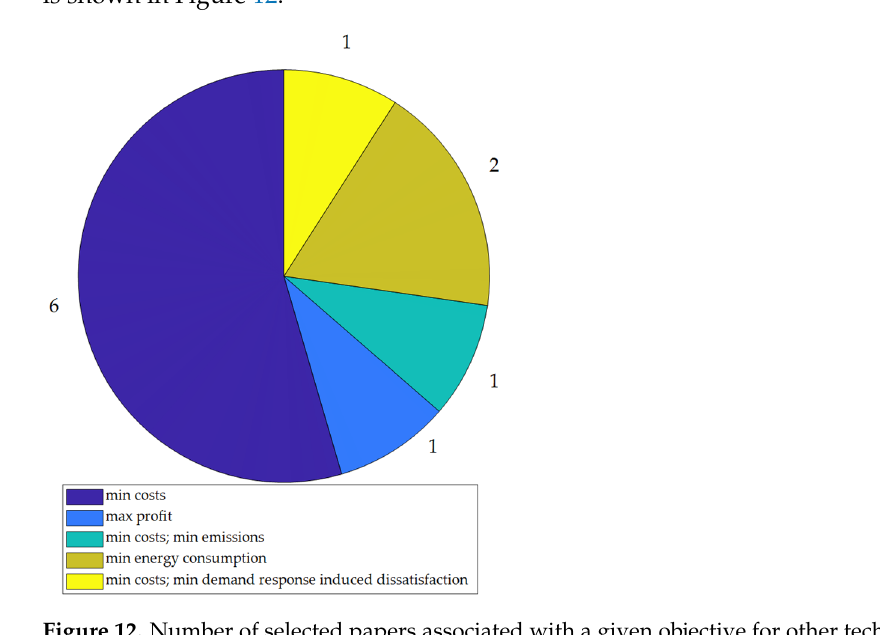
Figure 12. Number of selected papers associated with a given objective for other techniques.